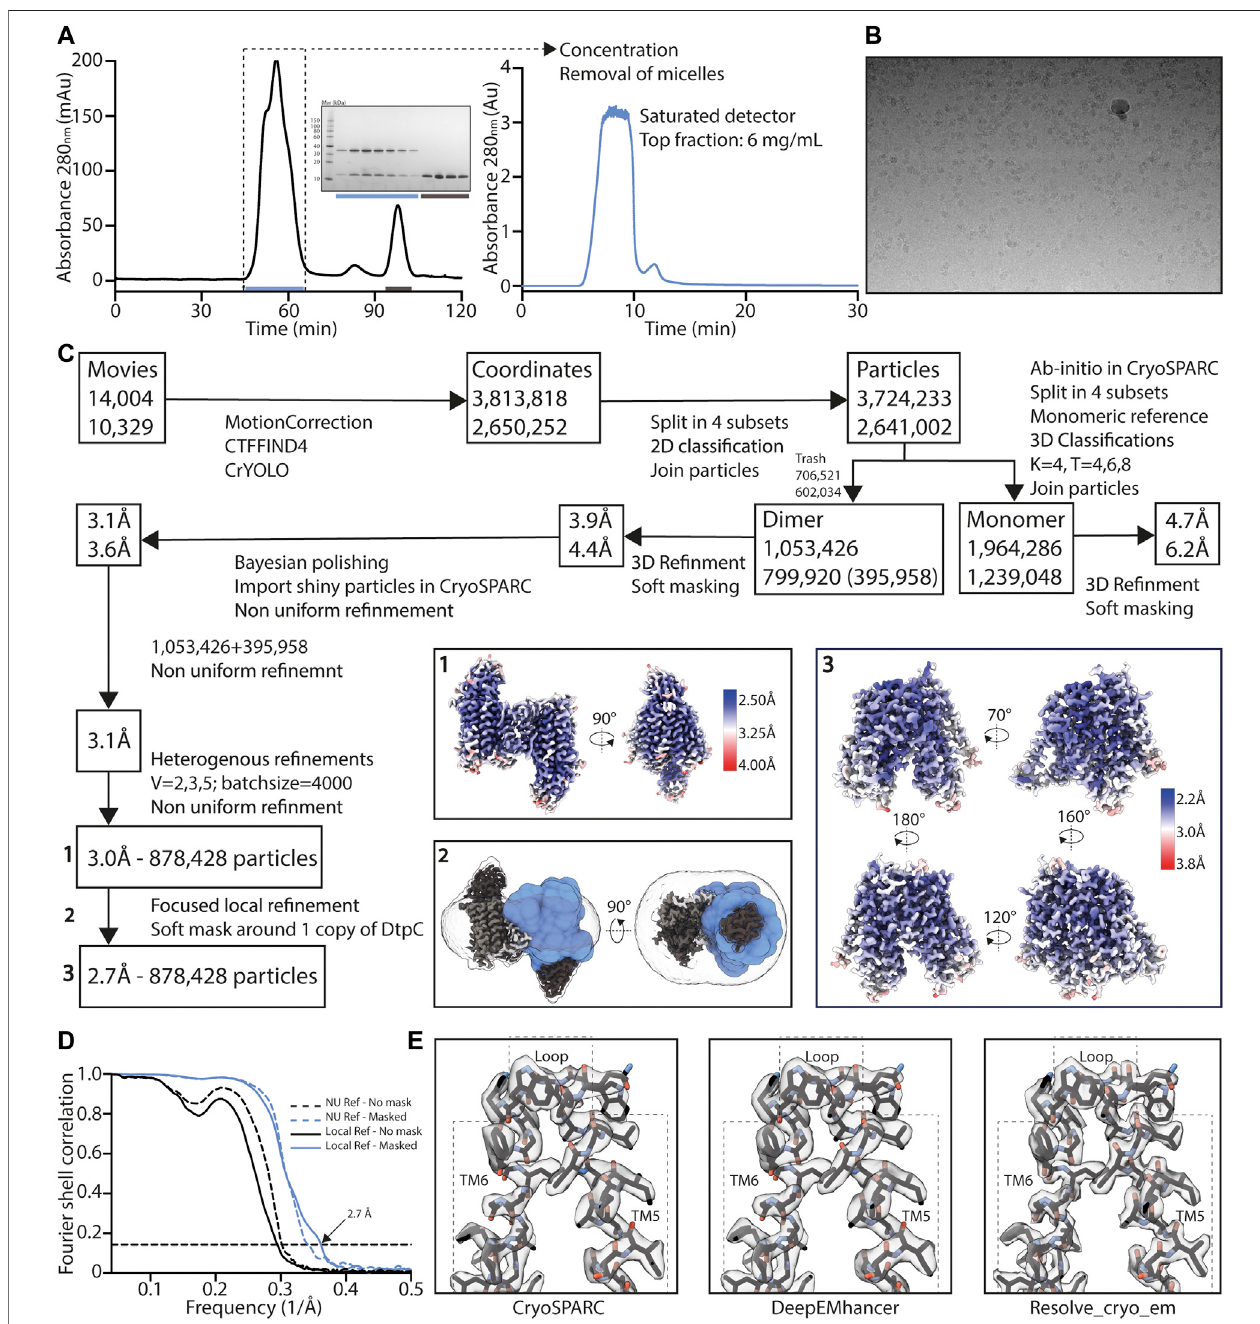
FIGURE 4 | HighresolutionstructuredeterminationofDtpC-Nb26. (A) Gel fi ltrationwasperformedonapreparativecolumn(left)beforeconcentratingthesampleto60 mg/ml and rerunning it on an analytic column on an HPLC system (right), in order to obtain a highly concentrated sample, free of empty detergent micelles. Peak shape already indicates a mixture of different oligomeric species. (B) Representative raw micrograph of the acquired dataset. The applied defocus is -1.5 µm. (C) Summary of the image analysis. The angular assignments from the dimeric reconstruction were used as prior to perform a local focused re fi nement with reduced angular and translational searches on the masked region illustratedinblue. (D) TheFouriertransformsoverdifferentshellsonfrequencyspace,oftwoindependentvolumes(halfmaps)werecompared(FSC)andplottedasafunctionofspatial frequency, to estimate the overall resolution using the 0.143 cutoff threshold. (E) The two half maps were used as inputs to assess various post-processing